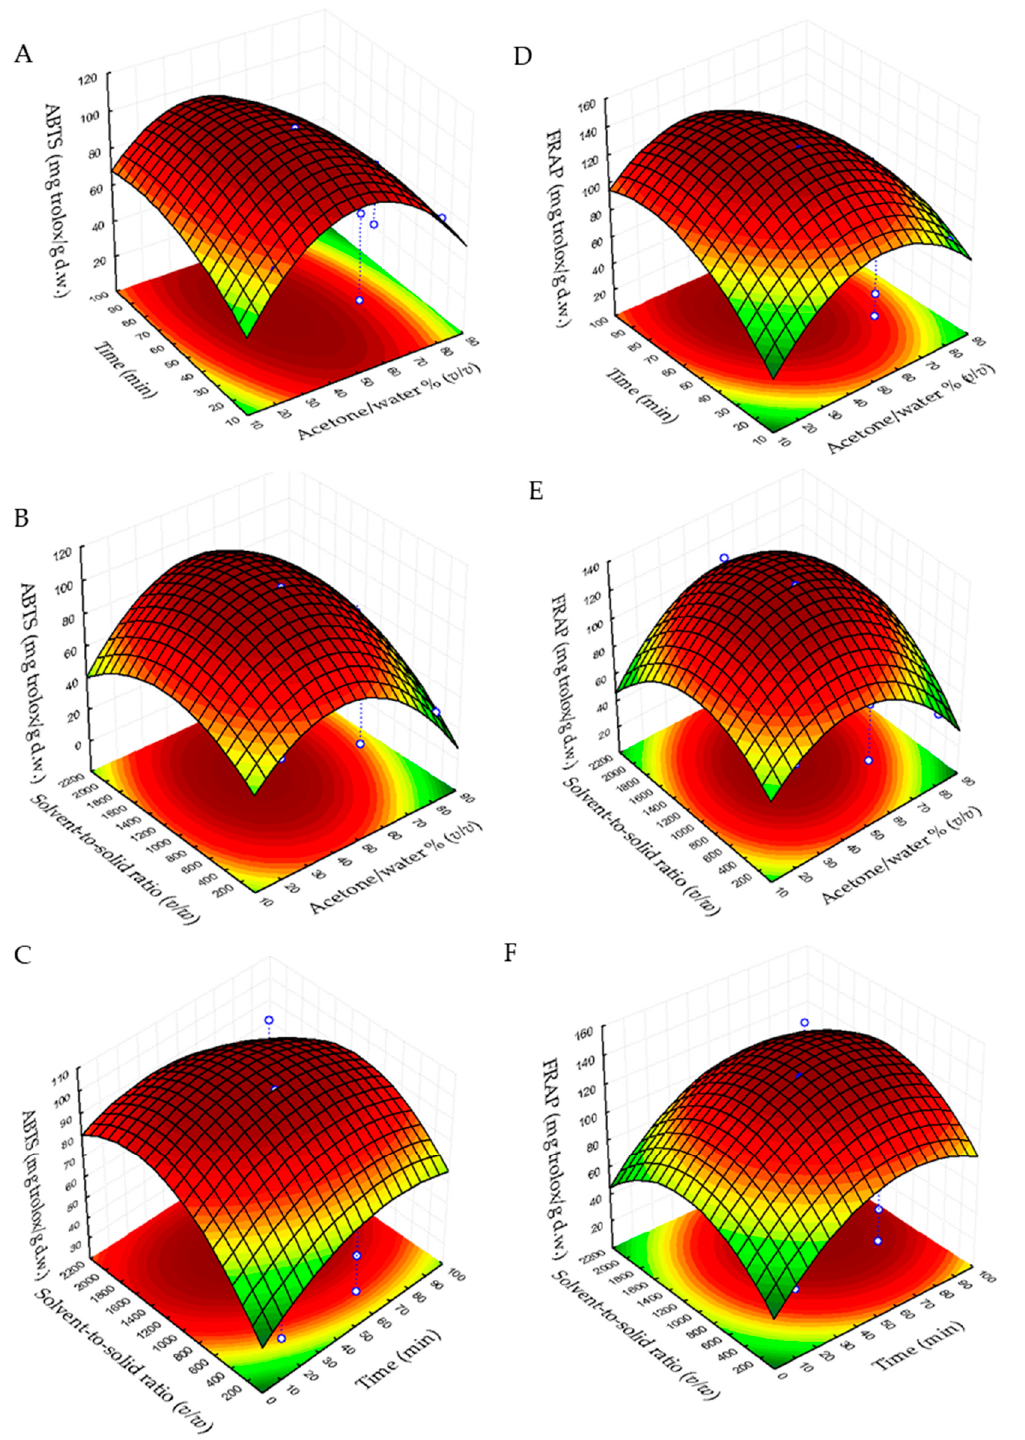
Figure 2. Response surface plots showing combined effects of process variables for ABTS and FRAP assays. ( A , D ) Solvent- to-solid ratio ( v/w ) vs. acetone/water % ( v/v ); ( B , E ) acetone/water ( v/v ) vs. time; and ( C , F ) solvent-to-solid ratio ( v/w ) vs. time.